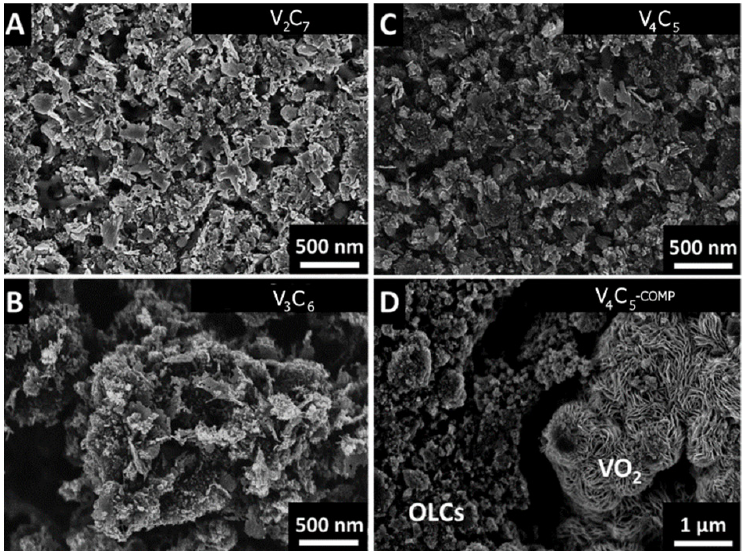
Figure 8. SEM micrographs of ( A ) V 2 C 7 , ( B ) V 3 C 6 , ( C ) V 4 C 5 , and ( D ) V 4 C 5 -COMP. Reprinted with permission from Ref. [129]. Copyright 2017 Royal Society of Chemistry.